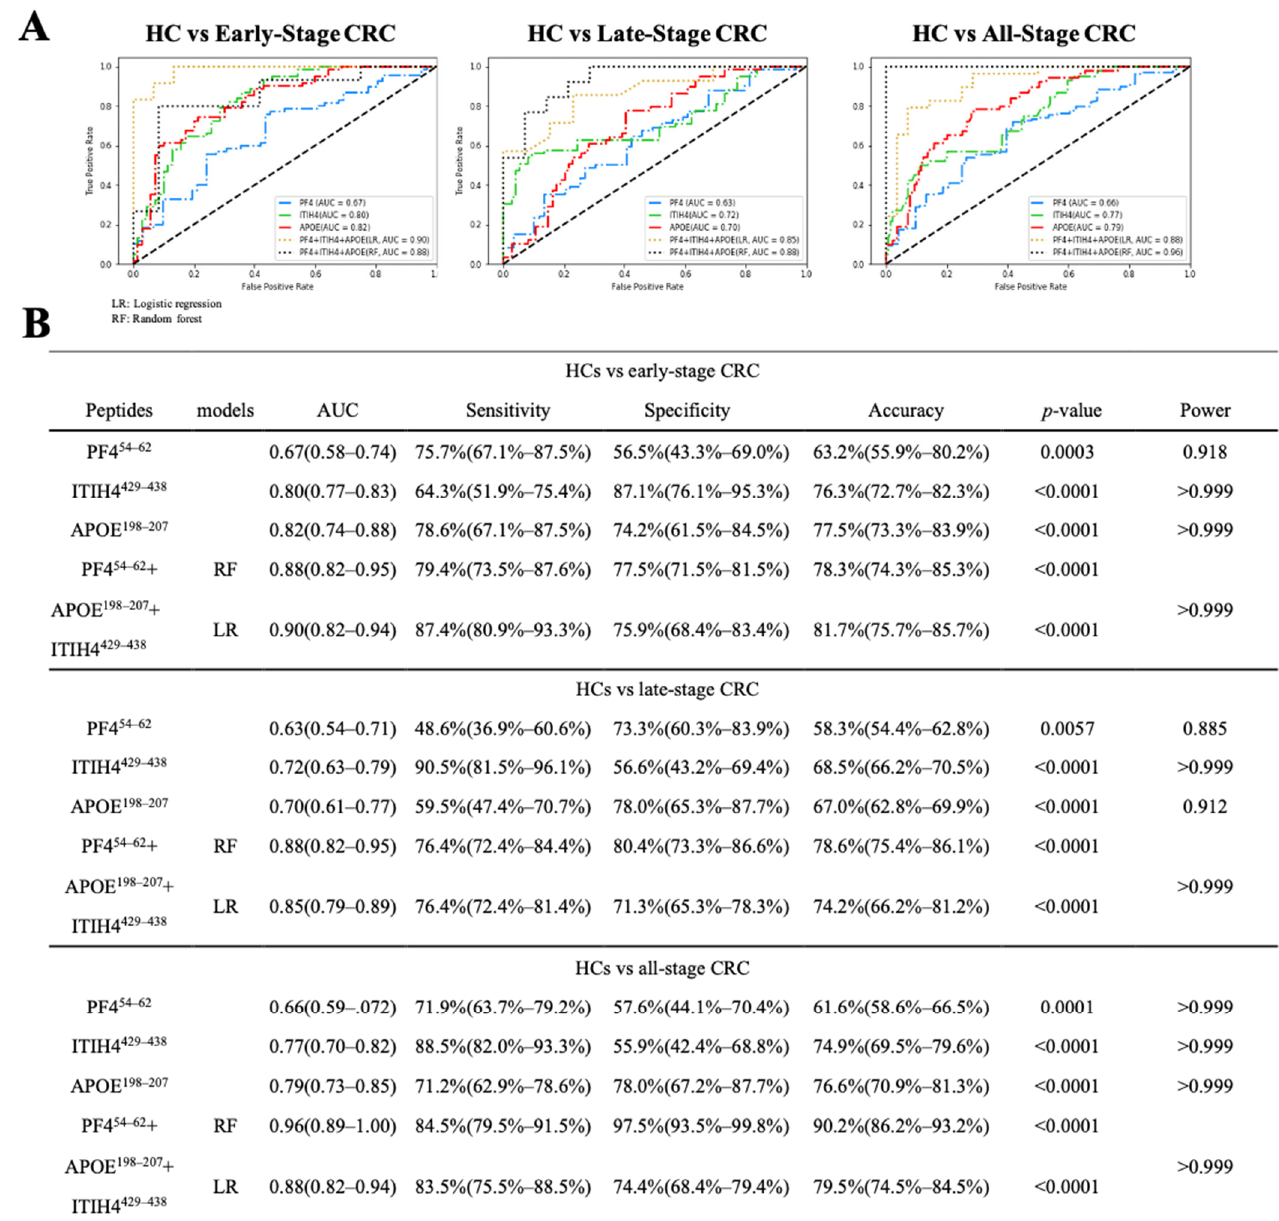
Figure 3. Comparison of receiver operating characteristics (ROC) curves ( A ) and predictive performance ( B ) from peptide factor 4 (PF4 54–62 ), inter-alpha-trypsin inhibitor heavy chain H4 (ITIH4 429–438 ), apolipoprotein E (APOE 198–207 ), and combinations of the three biomarkers with logistic regression and random forest in healthy controls (HCs) versus early-stage colorectal cancer (CRC), HC versus late-stage CRC, and HC versus all-stage CRC.